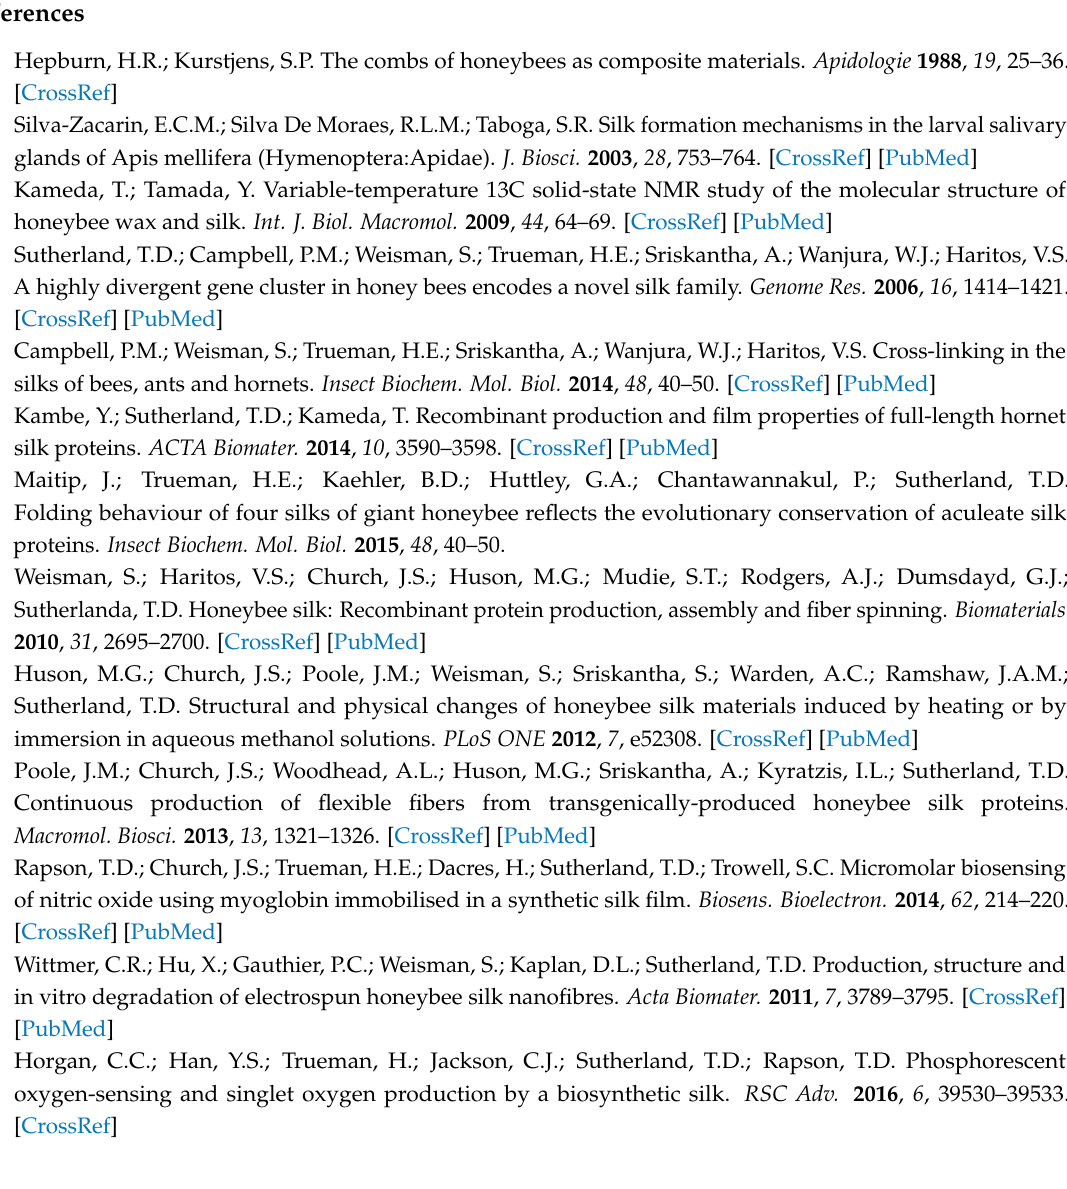
Figure S1. Bioinformatics predictions for the honeybee silk protein AmelF3: ( A ) MARCOIL and ( B ) Paircoil, Figure S2. Deconvolution of the amide I regions of the infrared spectra obtained from “as cast” ( top ) and 70% methanol treated ( bottom ) films of the peptides: ( A ) GK60, ( B ) AR99, ( C ) AR28, and ( D ) VF45, Figure S3. A solution bound single AR28 peptide modeled in an initially α -helical conformation ( A ) and the final observed conformation ( B ) after 100